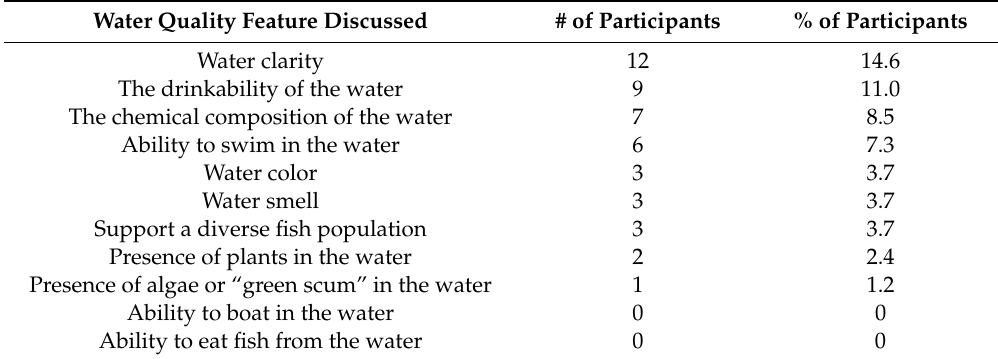
Table 4. Water quality features discussed in participant-generated definitions of water quality.